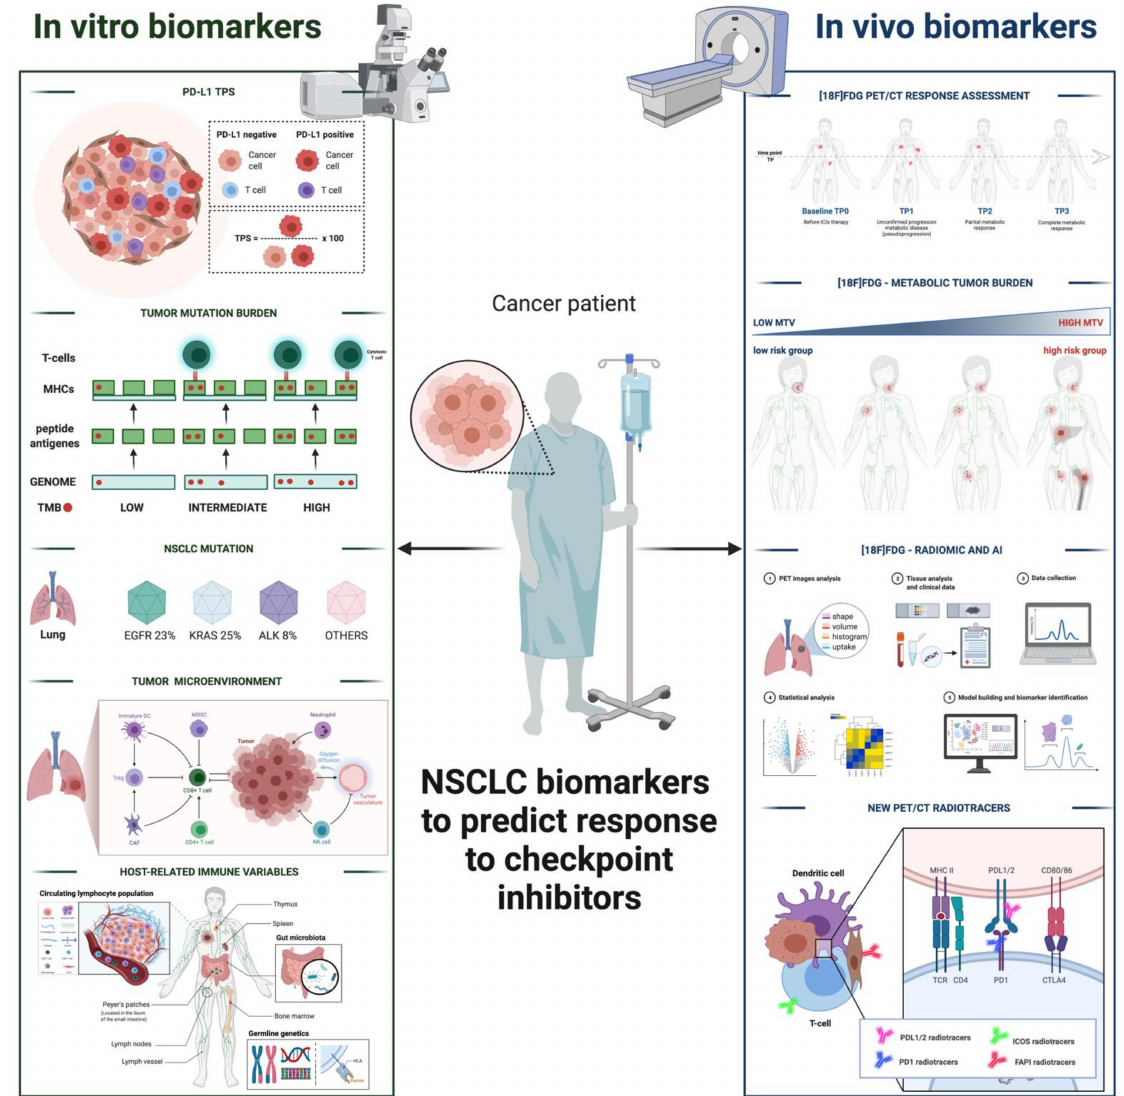
Figure 1. Overview of the main in vitro and in vivo biomarkers that may enrich the clinical benefit of ICI treatment NSCLC patient